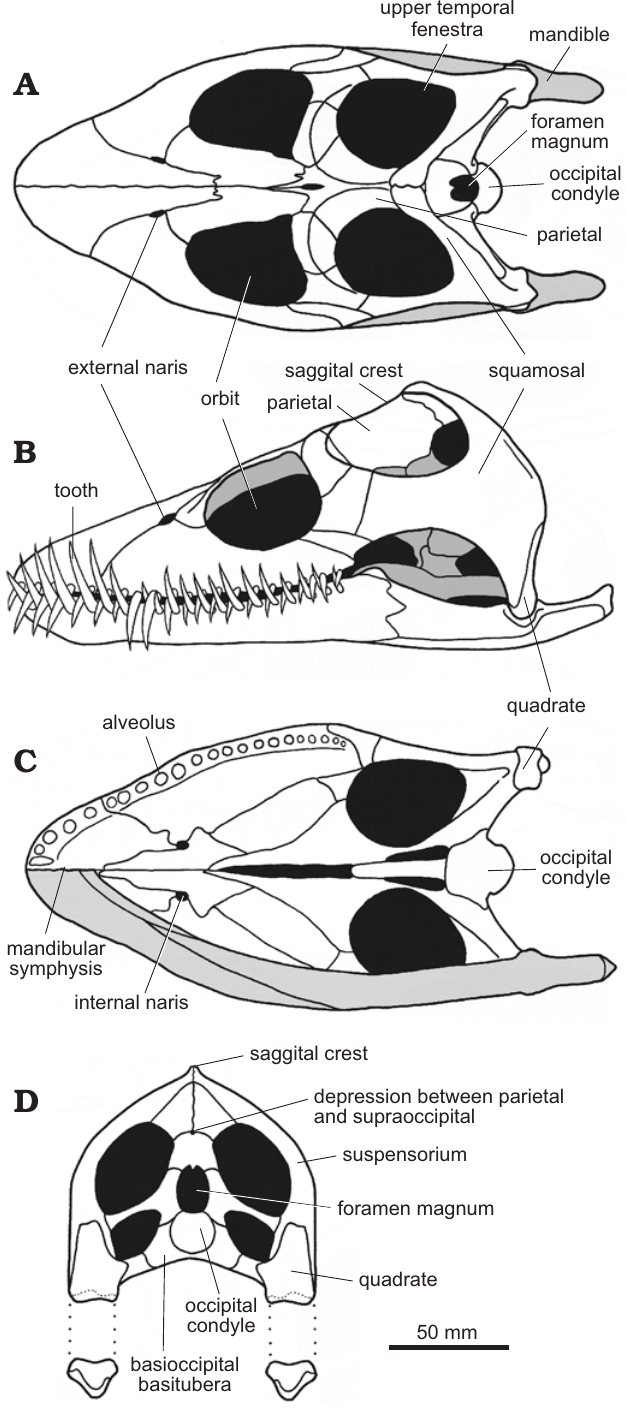
Fig. 4. Reconstructions of the cranium and mandible of the plesiosaur Muraenosaurus leedsi from the Oxford Clay Formation, Callovian and Oxfor dian, showing overall proportions and construction, and highlight- ing areas mentioned in the text. A . Dorsal view. B . Left lateral view. C . Ventral view with mandible removed (upper half) and mandible shaded grey (lower half). D . Posterior view with mandible shown disarticulated. Images modified from: A, Evans (1999); B, Evans (1999) with dentition added based on information from Andrews (1913) and Brown (1981b); C, D, compiled from LFN drawings and Andrews (1910), Brown (1981b), and Evans